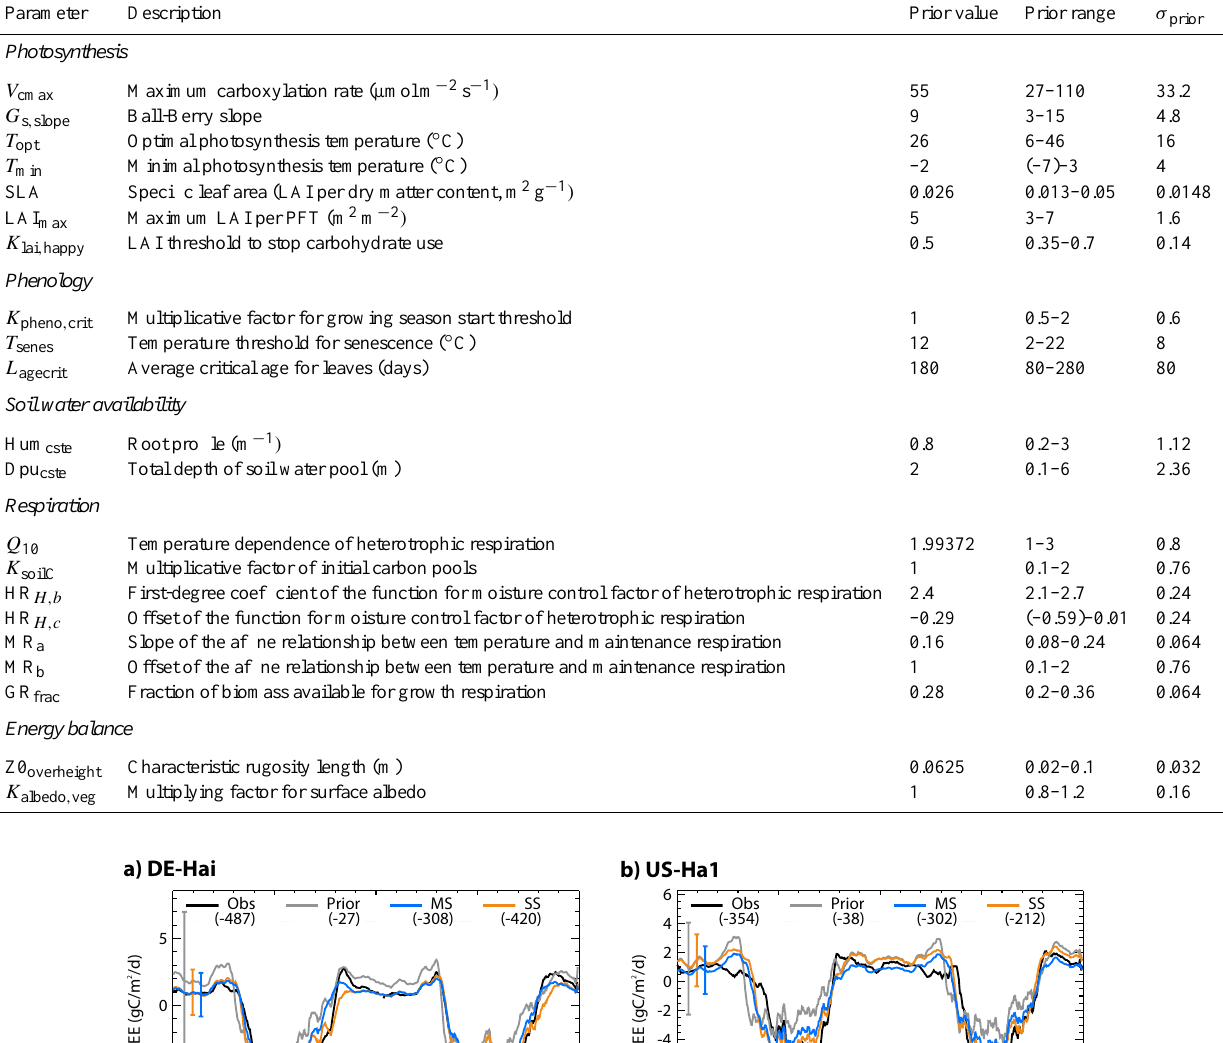
Table 2. ORCHIDEE parameters optimized in this study.